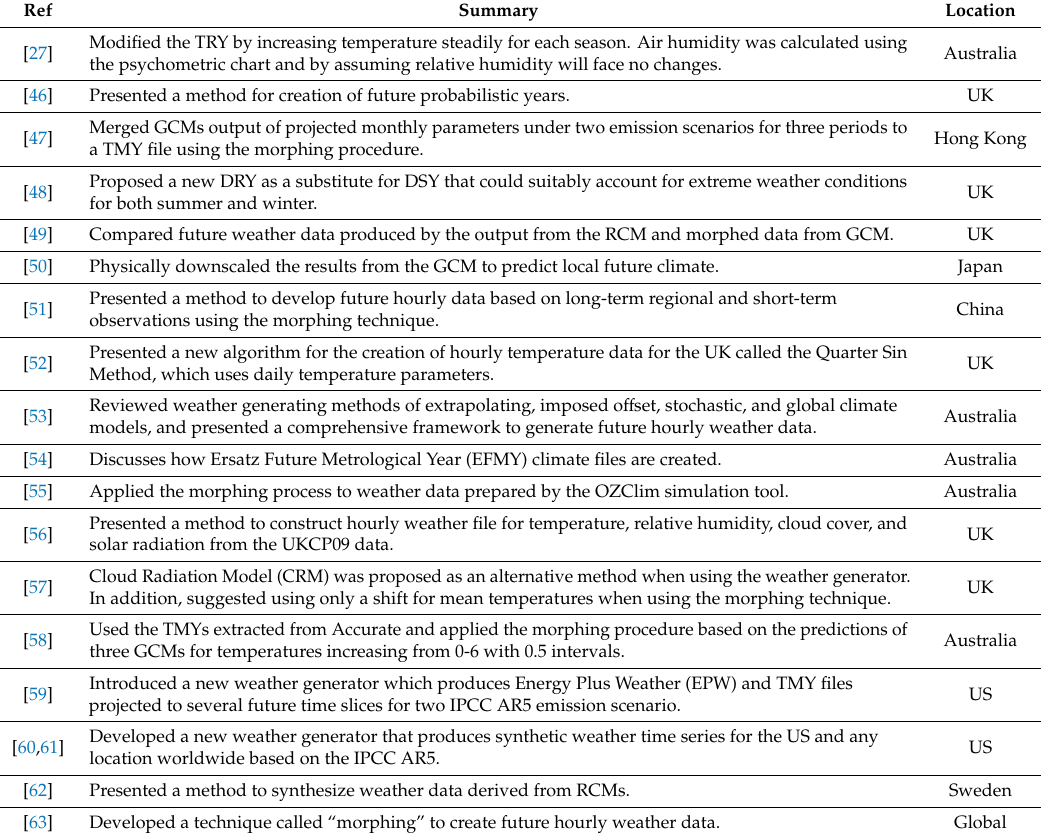
Table 2. Summary of literature on generation and modification of future hourly weather files for building